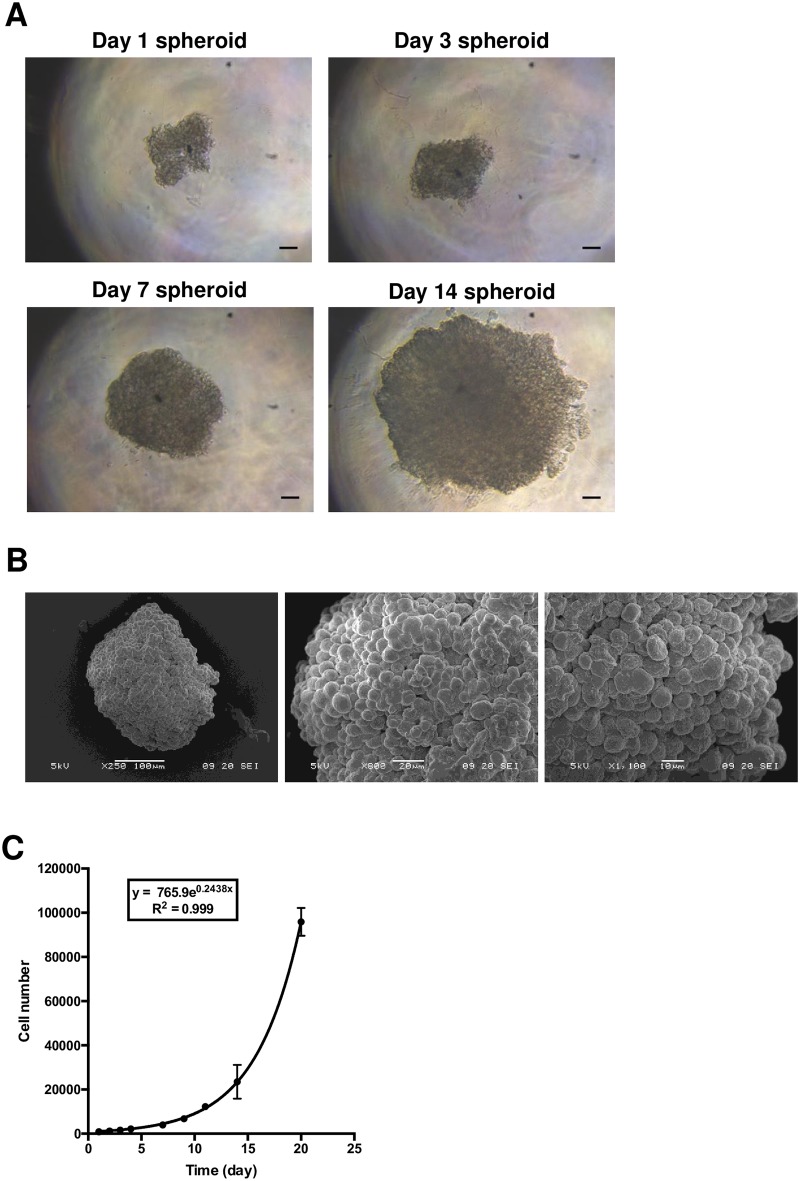
Formation of HEMC-SS spheroids.To generate spheroids, 1000 human chondrosarcoma HEMC-SS cells were seeded in a non-adherent 96-well plate in a solution of 0.5% methylcellulose diluted in corresponding culture medium. (A) Optical visualization of HEMC-SS spheroids at different stages of development. Scale bar = 100 μm (B) SEM imaging of one representative spheroid at Day 14. (C) Cell count of trypsin-dissociated spheroids.